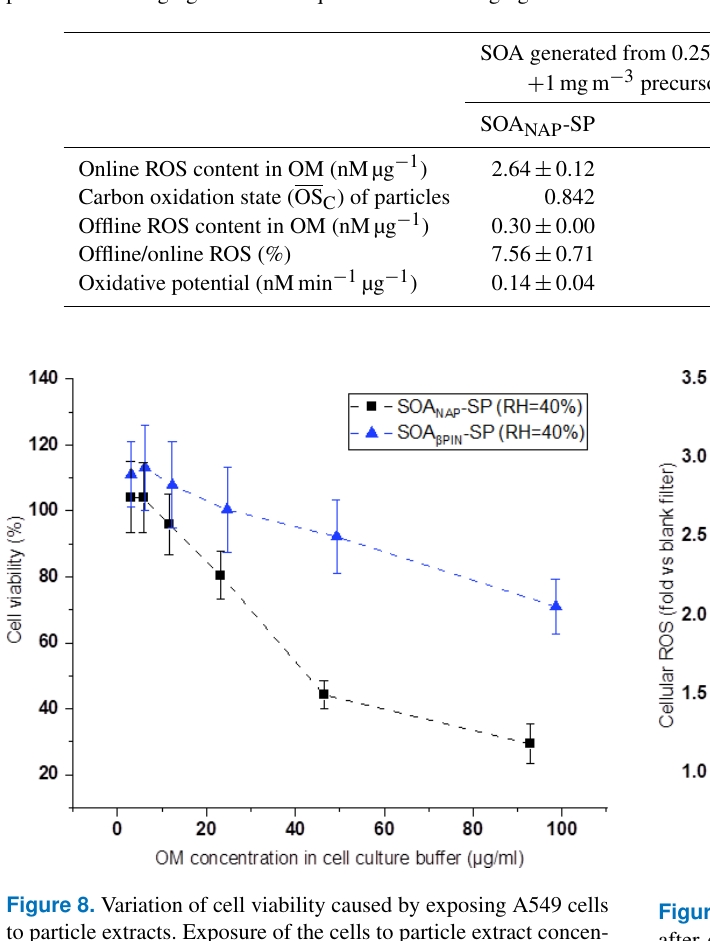
Table 1. Comparison of the oxidative characteristics of particles generated from different concentrations of soot and precursor VOCs under photooxidation aging conditions equivalent to 3d of aging at 40% RH.